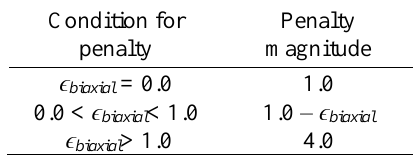
Table 1. Penalty values for biaxial